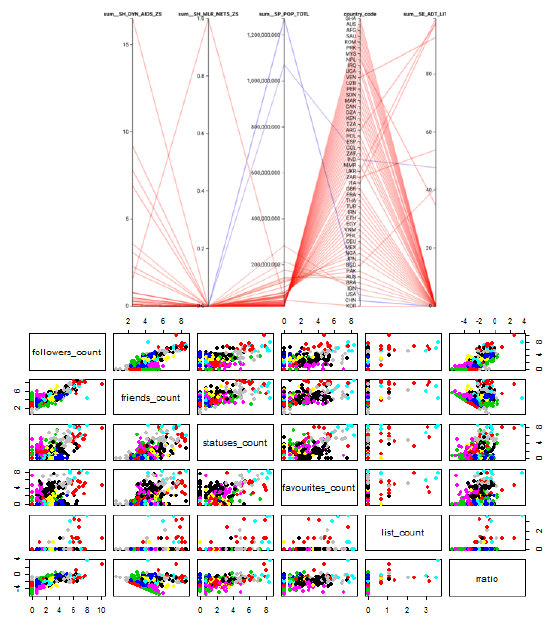
Figure 3. Parallel Coordinates (upper) and Scatterplot Matrix (bottom) Examples (URL-2)